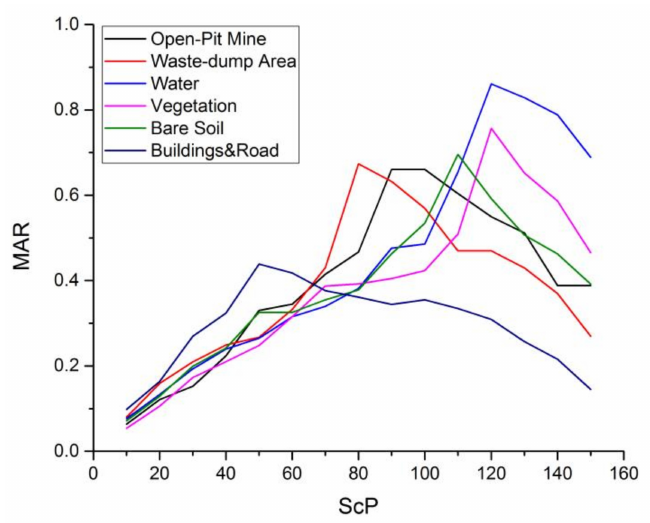
Figure 4. Map of mean area ratio (MAR) values vary with the Scale parameter (ScP).